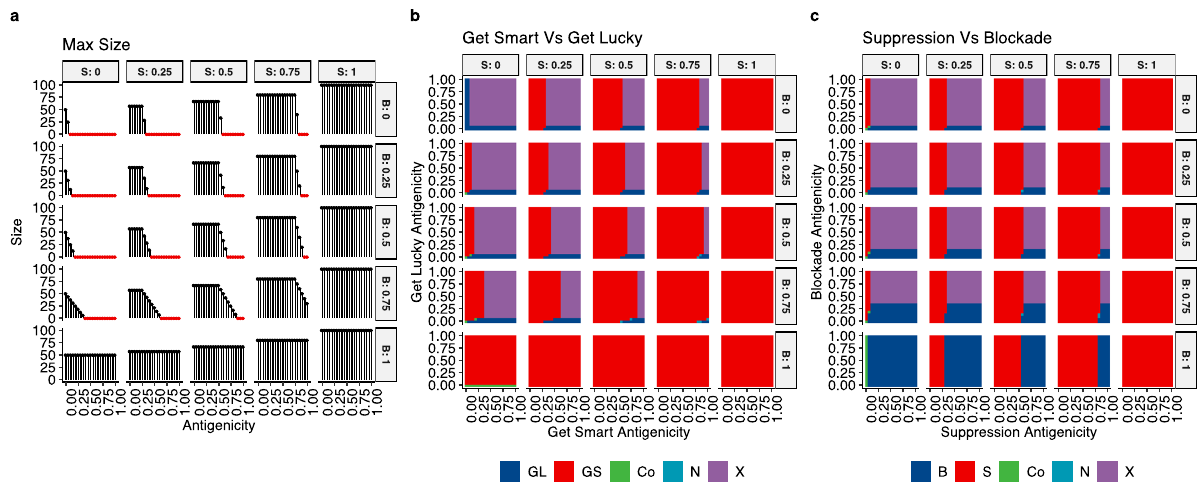
Fig. 1 Model results predict that immune suppression is the dominant escape mechanism. a Maximum size (i.e., number of cells) of each strategy for different values of suppression (S, σ , columns), blockade (B, ϕ , rows), and antigenicity (inset x -axes). Red dots indicate that the population is eliminated by immune predation, highlighting that clones must have some way to avoid immune predation, either by having low antigenicity (Get Lucky) or actively mitigating attack (Get Smart). As population growth was simulated using an epithelial division rate, these results indicate immune escape should be an early event if the clone is to survive increased predation due to the accumulation of neoantigens associated with the mutation. b , c Outcome of competition, where “ Co ” means neither strategy would go extinct and could co-exist, “ N ” , indicates either strategy could win, but the one that does must have a larger starting population size, and “ X ” means that neither population survived immune predation. b Outcomes of competition between Get Lucky (GL) and Get Smart (GS), over a range of suppression values (S, σ ), blockade values (B, ϕ ), and antigenicities ( γ ), such that for GL σ = 0 , ϕ = 0, and for GS 0 ≤ ϕ ≤ 1, 0 ≤ ϕ ≤ 1. Get Smart wins out over Get Lucky 71% of the time (7778 out of 11025 parameter combinations). c Outcomes of competition between Suppression (S) and Blockade (B), over a range of suppression values (S, σ ), blockade values (B, ϕ ), and antigenicities ( γ ), such that for P σ = 0, 0 ≤ ϕ ≤ 1, and for S ϕ = 0, 0 ≤ σ ≤ 1. Out of the 11,025 parameter combinations, Suppression (S) wins the majority of the time, 55% (6047 parameter combinations), with Blockade (B) winning 17% of the time (1862 parameter combinations). Combined, these results highlight that Get Smart almost always wins out over Get Lucky, while Suppression wins against Blockade. This indicates that having an immune escape strategy (Get Smart), particularly immune suppression, signi fi cantly increases a clone ’ s fi tness, allowing it to sweep through the population, often by engineering an immunosuppressive